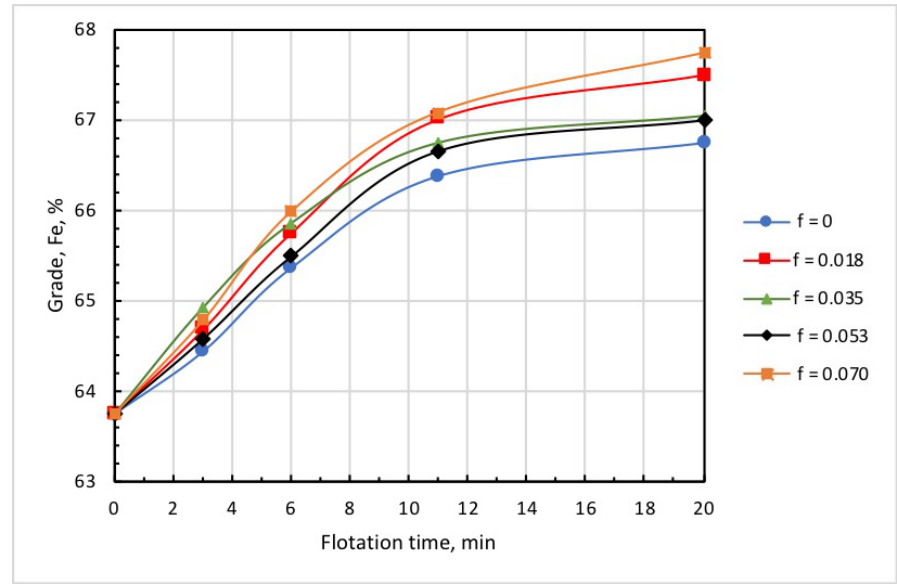
Figure 9. Kinetics of concentrate grade at different doses of microbubbles f (mL/g) introduced before flotation start: collector dose, 20 g/t; airflow rate, 0.18 L/min.